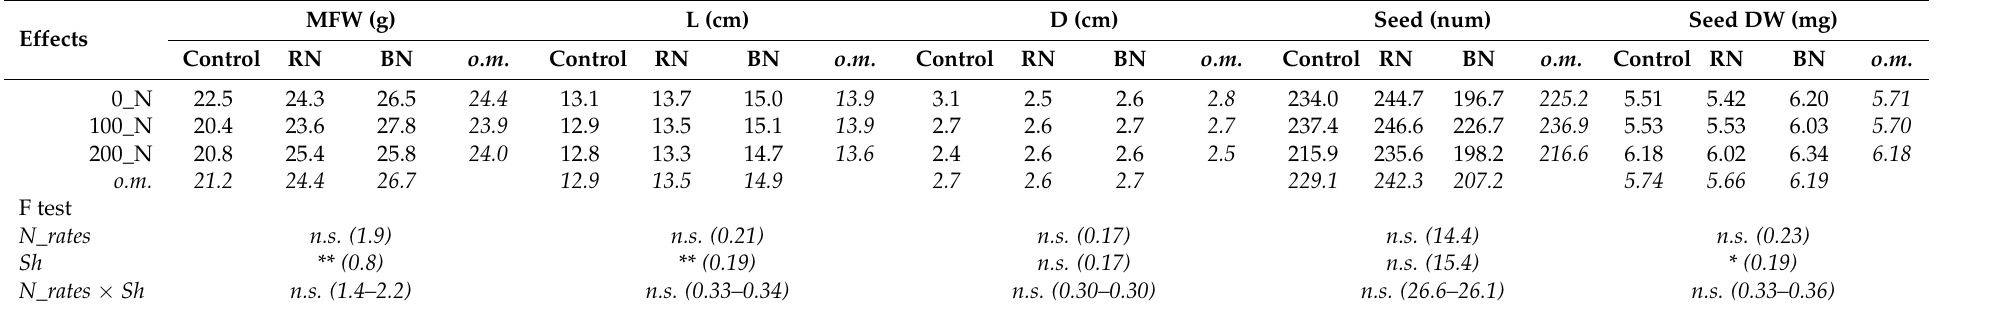
Table 2. Mean marketable fruit weight (MFW, g), fruit length (L, cm), fruit diameter (D, cm), number of seeds per fruit (Seed, num) and single-seed dry weight (Seed DW, mg), as recorded in pepper plants subjected to different N fertilization rates (N_rates; 0_N: 0 kg N ha − 1 ; 100_N: 100 kg N ha − 1 ; 200_N: 200 kg N ha − 1 ) and shade levels (Sh; accomplished using: no cover, Control; red photoselective net, RN; black photoselective net, BN) in 2017 a